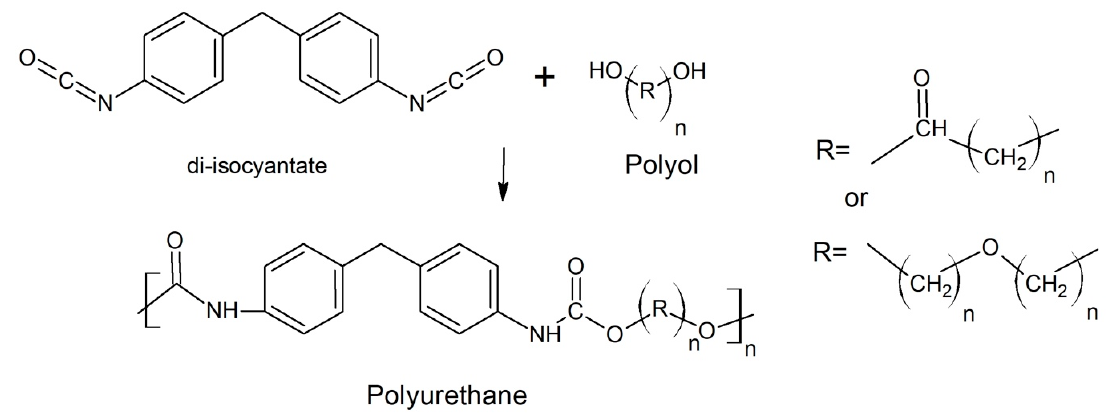
Figure 2. Polyurethane synthesis reaction example.